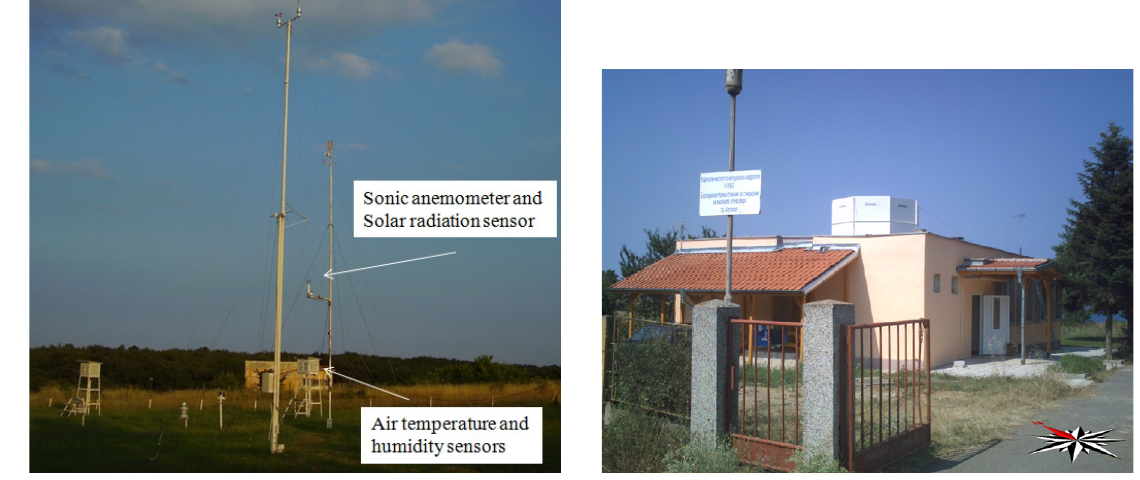
Figure 2. Location of sensors at the meteorological observatory (MO) Ahtopol (left). The SODAR is mounted on the roof of the adminis- tration building